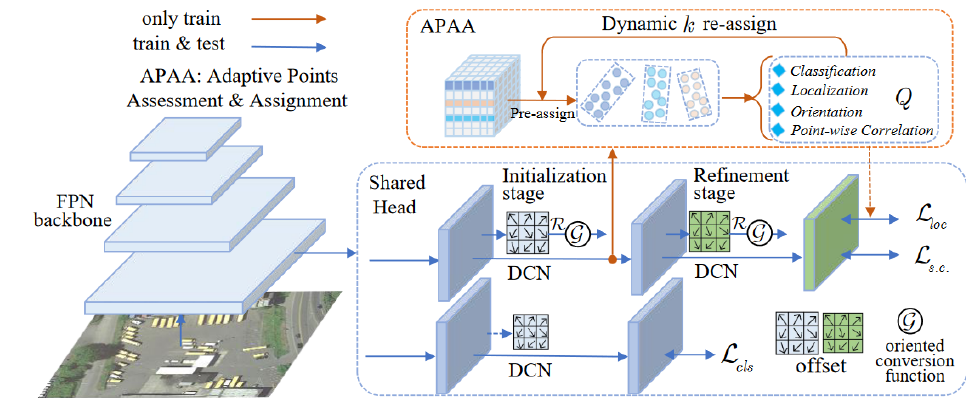
Figure 7. Overview of the anchor-free Oriented RepPoints detection architecture [46] that strives to learn selecting points samples for classification, regression and orientation. RepPoints utilizes the same structure of the shared head as in [46], except a quality assessment and sample assignment strategy (APAA) are employed for selecting high-quality sample points for training. Figure is adapted with permission from [46]. Best viewed zoomed in.